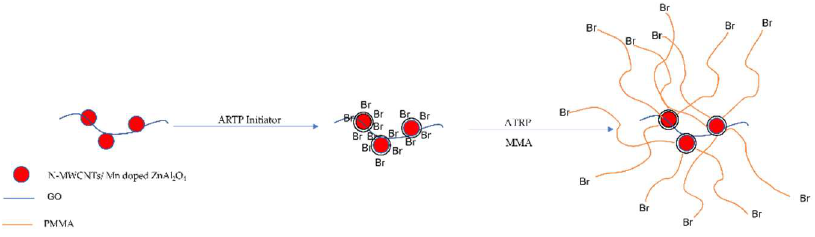
Figure 1. The scheme of surface-initiated atom transfer radical